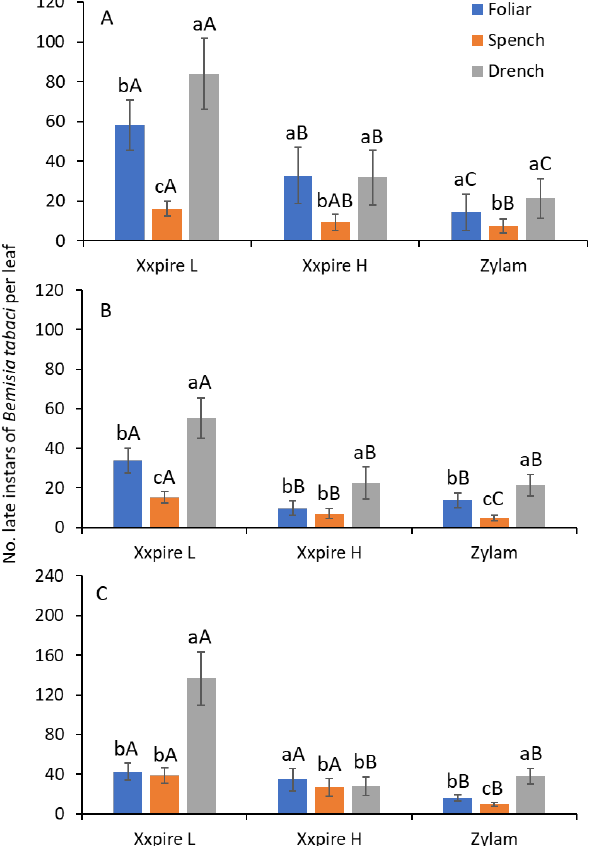
Figure 2. Late instars. Least-squares mean (±SE) numbers of late instars of B. tabaci observed on poinsettia leaves treated with various insecticides and application methods in the greenhouse at ( A ) 14, ( B ) 21, and ( C ) 28 days after application. Same lower-case letters among methods within insecti- cide treatment are not significantly different at α = 0.05 ( Tukey – Kramer test), and same upper-case insecticide treatment are not significantly different at α = 0.05 (Tukey–Kramer test), and same upper- letters among same- colored bars (application method) are not significantly different at α = 0.05 case letters among same-colored bars (application method) are not significantly different at α =